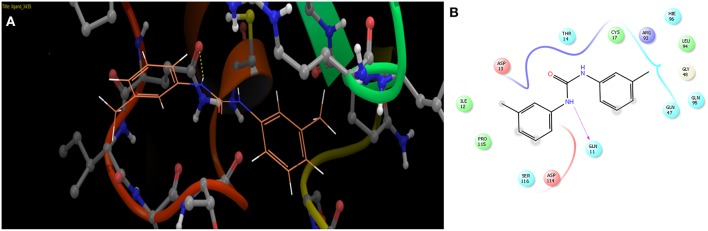
(A) Binding of ComAI with PEP domain of ComA through Hydrogen bonding (yellow dotted line). (B) Schematic 2D representation of Ligand interaction pattern of ComAI (ComA Inhibitor) with PEP domain of ComA.